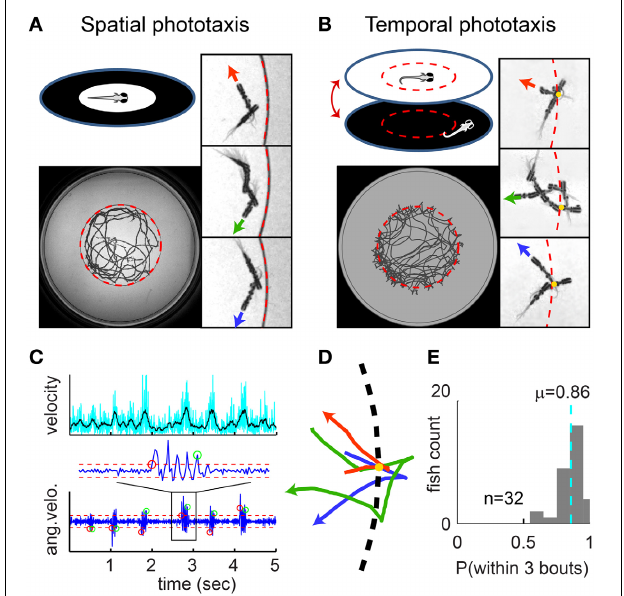
FIGURE 1 | Spatial vs. temporal phototaxis. (A) Larval zebrafish prefer light over darkness in the spatial comparison assay. Upper left: a diffusive (scattering) white screen surrounded by an opaque black ring is placed beneath the arena (a transparent dish) and illuminated from below. Lower left: the full trajectory of a fish over a session of 8min. Right panels: close-up views of trajectory segments close to the border. Three example segments are shown (rotated into the same orientation), with swim direction indicated by the red, green, and blue arrowheads; circular border indicated by the dashed red line. Note that the fish does not cross the border. (B) Temporal comparison assay, i.e., the Virtual Circle (VC) assay. The uniform illumination is turned off when the fish exits the virtual circle (dashed red circle, invisible to fish), and turned on again when the fish returns. Close-up view as in (A) , additionally with yellow dots marking the point where the fish exits the virtual circle. (C) Larval zebrafish swim in distinct bouts. Upper panel: velocity of the fish over time. Lower panel: bouts are determined by thresholding the angular velocity (i.e., per-frame change of heading angle); red/green circles mark the start/end of bouts, dashed red lines mark the thresholds. (D) Trajectory segments close to the virtual border are extracted from the VC assay, with the point where fish exits the border aligned to the yellow dot. Three example segments are shown in red, green and blue, with swim direction indicated by arrowhead. (E) The probability of each fish returning to light within 3 bouts of exiting the virtual circle, summarized as a histogram for all 32 fish. Dashed cyan line indicates population